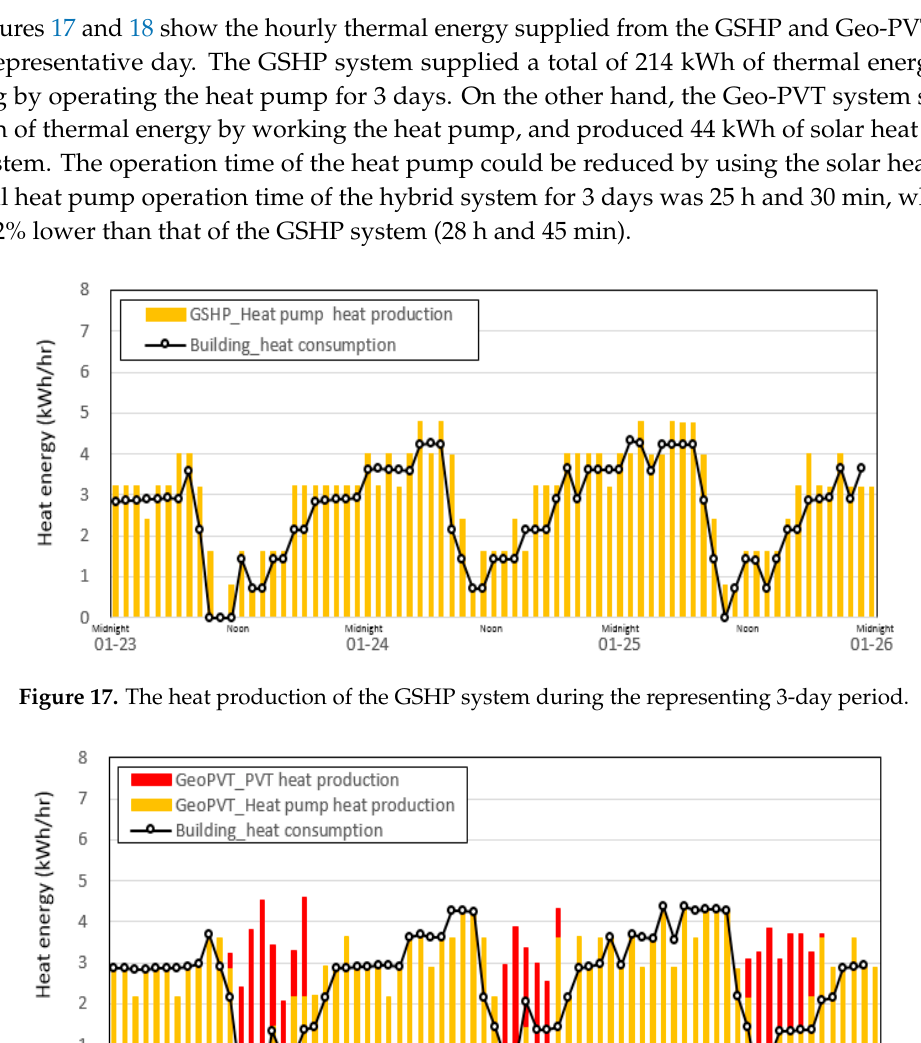
Figure 16. Ambient temperature and solar radiation in January.